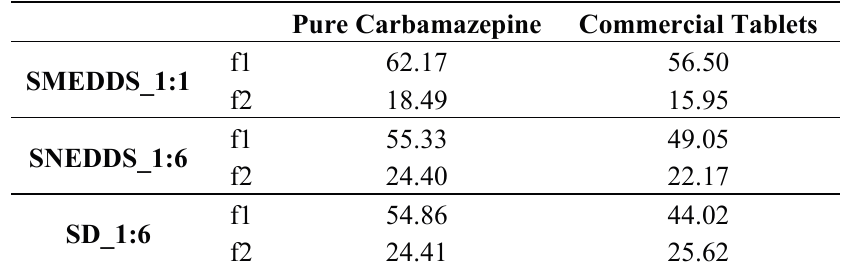
Table 1. Difference factors (f1) and similarity factors (f2) of formulation and pure carbamazepine and commercial